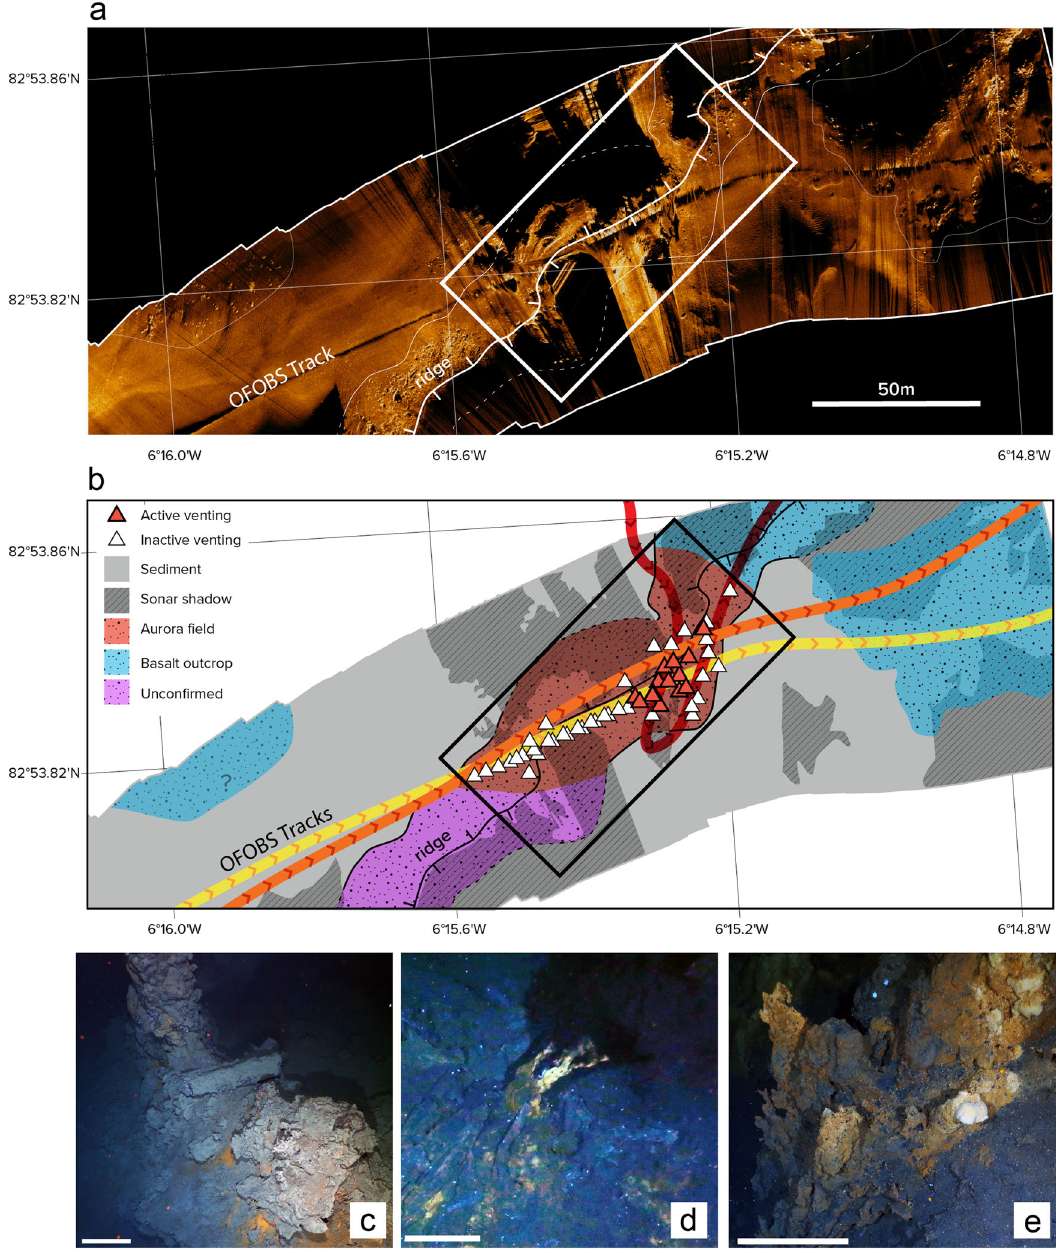
Fig. 2 | Results from high resolution deep-tow (OFOBS) surveys of the sea fl oor at Aurora hydrothermal fi eld. a High-frequency sidescan sonar image of the sea fl oor crossing the Aurora vent- fi eld, Gakkel Ridge from the OFOBS-07 survey. b Corresponding geological map based on sidescan interpretation coupled with deep-tow camera ground-truthing (dive tracks are in the same colors as Fig. 1, arrows show direction of travel). Observations of extinct sul fi des are located as white triangles; observations of active fl uid fl ow are located as red triangles. The ridgealongwhichtheventsaredistributedisshownasasolidlinewithtickmarksto indicate the downhill direction in ( a ) and ( b ) and the rectangle bracketing the con fi rmed hydrothermal fi eld in both panels measures 50mx100m. Note, how- ever,thatthesouthernlimittotheAurora fi eld,along-ridge,remainsunconstrained